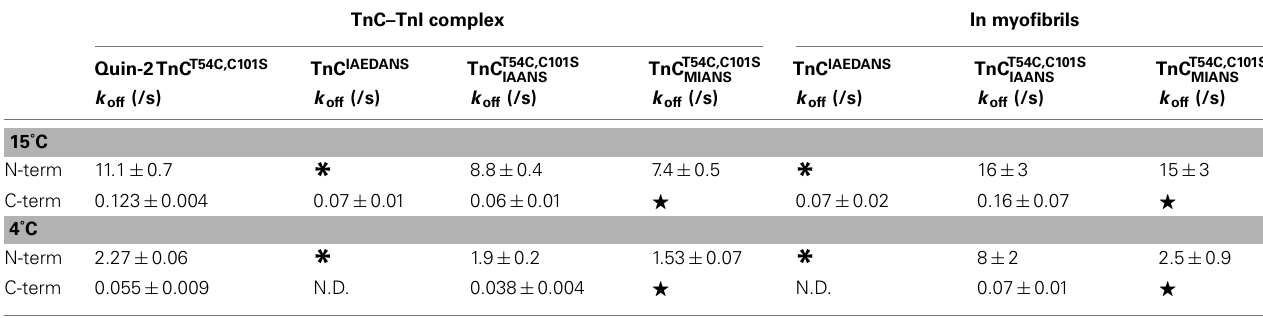
Table 2 | Comparison of calcium dissociation kinetics from the differentTnC constructs in the presence ofTnI and myofibrils. TnC–TnI complex In